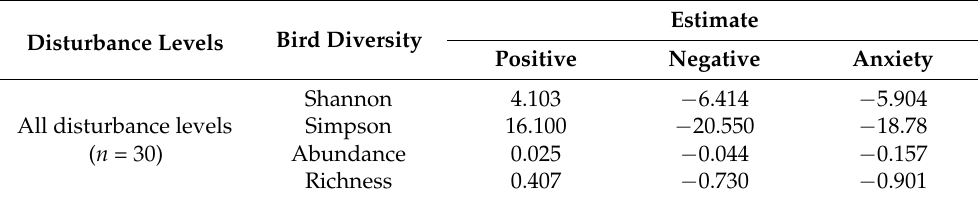
Table 2. Estimate for linear regression models testing whether three measures of psychological well-being (positive affect, negative affect, and anxiety) can be predicted by four different measures of bird diversity (species richness, abundance, Shannon diversity, and Simpson diversity) across all sites, high disturbance sites, moderate disturbance sites, and low disturbance sites. Star notation indicates significance level.